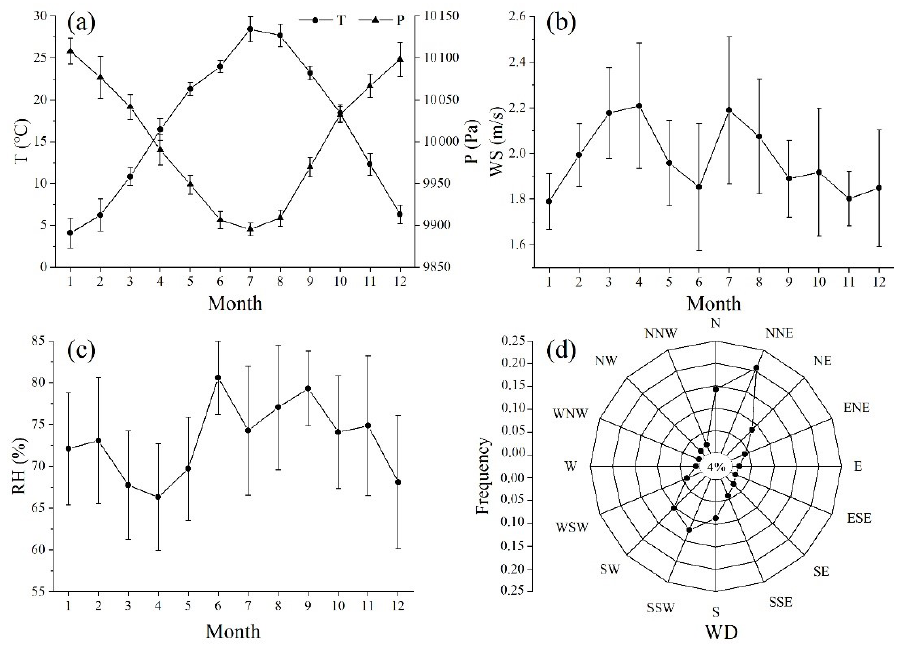
Figure 1. Seasonal variations in (a) temperature, air pressure, (b) WS, (c) RH, and (d) WD frequency distribution (the static wind frequency was 4%) at the LAN station from 2006 to 2017 (an error bar represents 1 standard